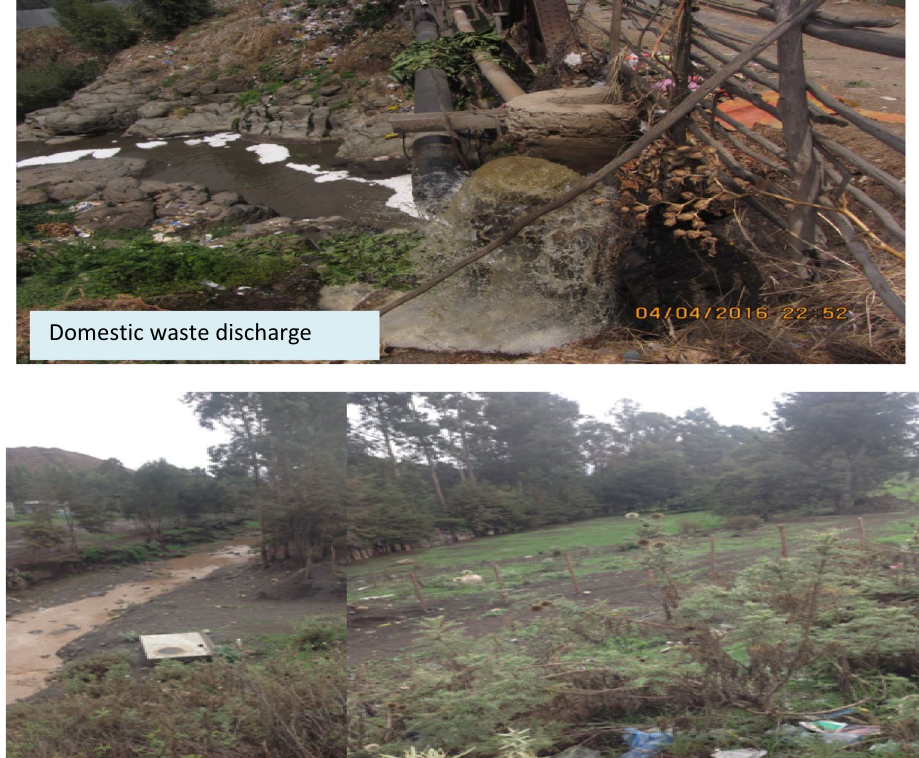
Fig. 13 Source, waste disposal, and potential recreational area along big Akaki River. Source Addis Ababa Rivers, and Riversides